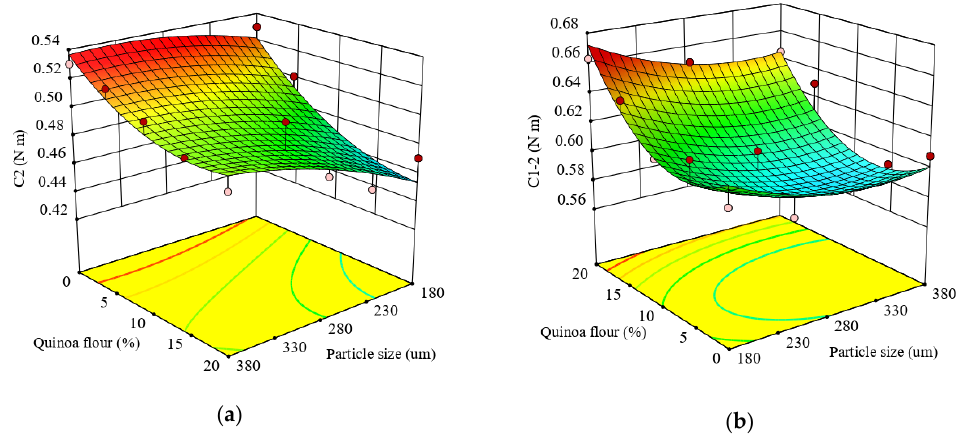
Figure 2. Response surface graph for combined effects of quinoa flour particle size and level added in refined wheat flour on Mixolab parameters during protein weakening stage: ( a ) C2 torque (C2) and ( b ) difference between torques C1 and C2 (C1–2).